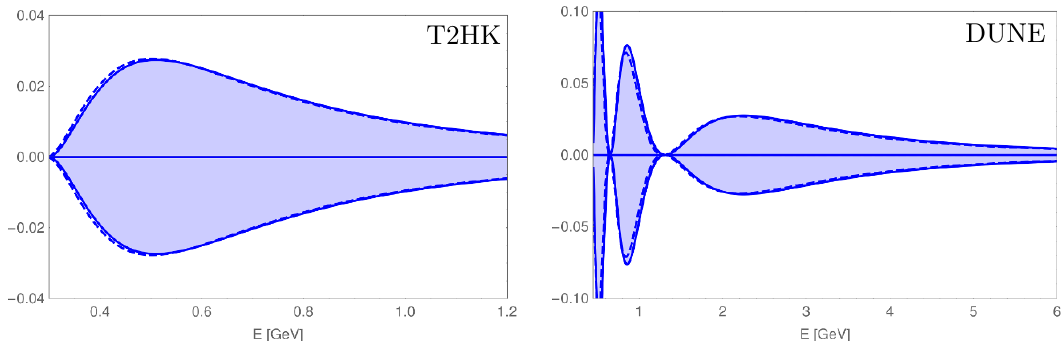
Figure 5 . Energy distribution of the T-odd component of A CP at T2HK L = 295 km (left) and (cid:22)e DUNE L = 1300 km (right), which is Hierarchy independent. Both the exact (dashed) and the analytical (solid) results from eq. (3.25b) are shown. The bands correspond to all possible values changing (cid:14) in (0 ; 2 (cid:25) ); the upper/central/lower lines correspond to sin (cid:14) = (cid:0) 1 ; 0 ; 1. Notice the di(cid:11)erent energy range and scale of the asymmetry between T2HK and DUNE